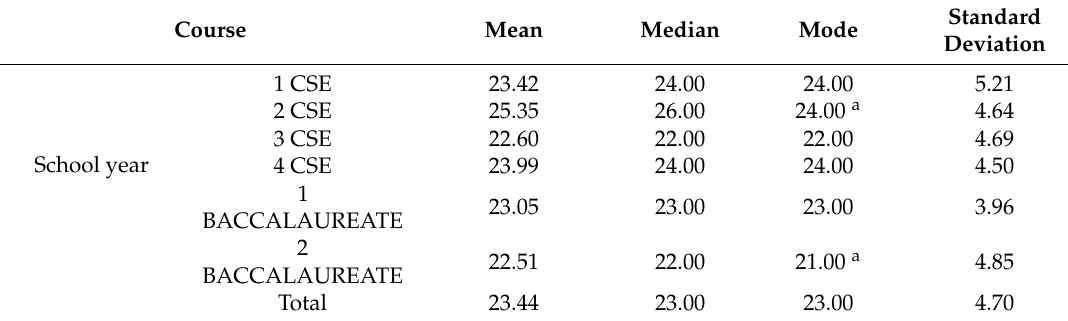
Table 3. Descriptive statistics relating to the present